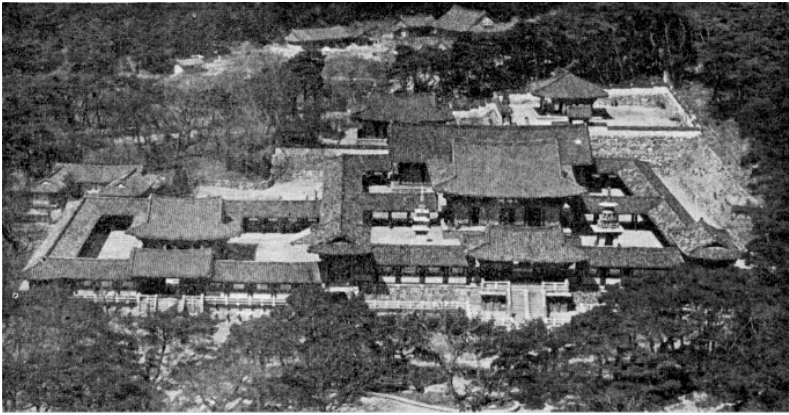
Figure 1. Whole view of Bulguksa after the 1969–73 restoration work (source: Dongailbo, 16 March 1976).